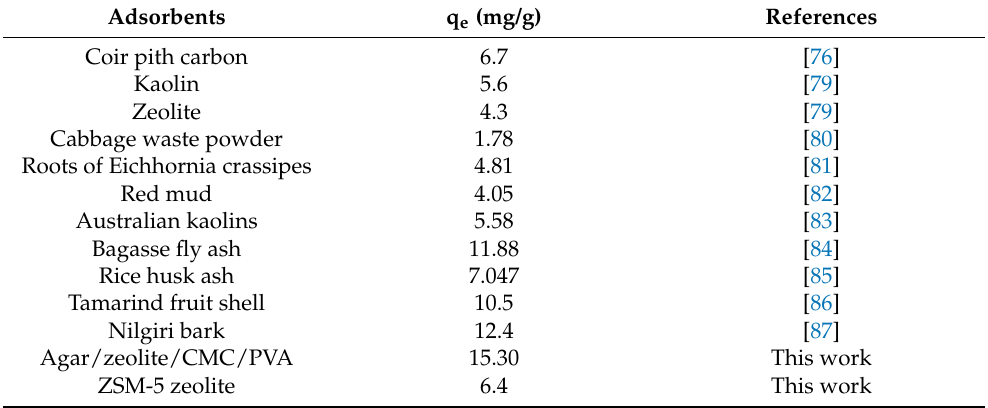
Table 8. Comparison studies of previous work on CR dye on various